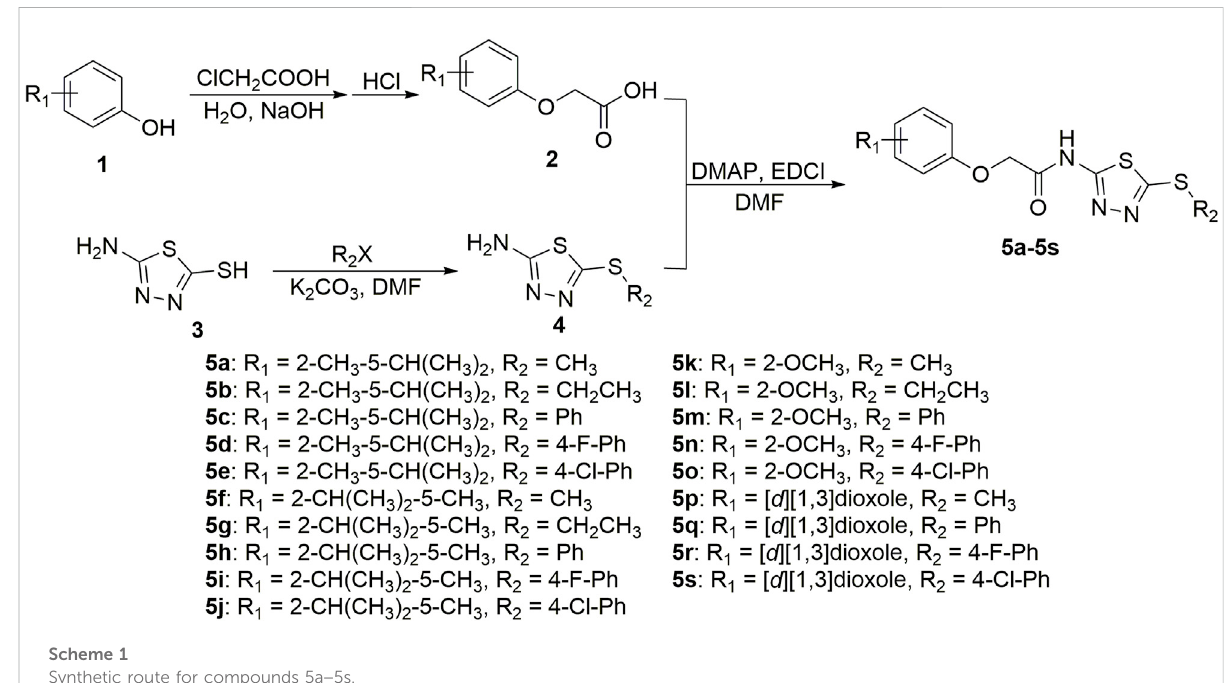
Scheme 1 Synthetic route for compounds 5a −